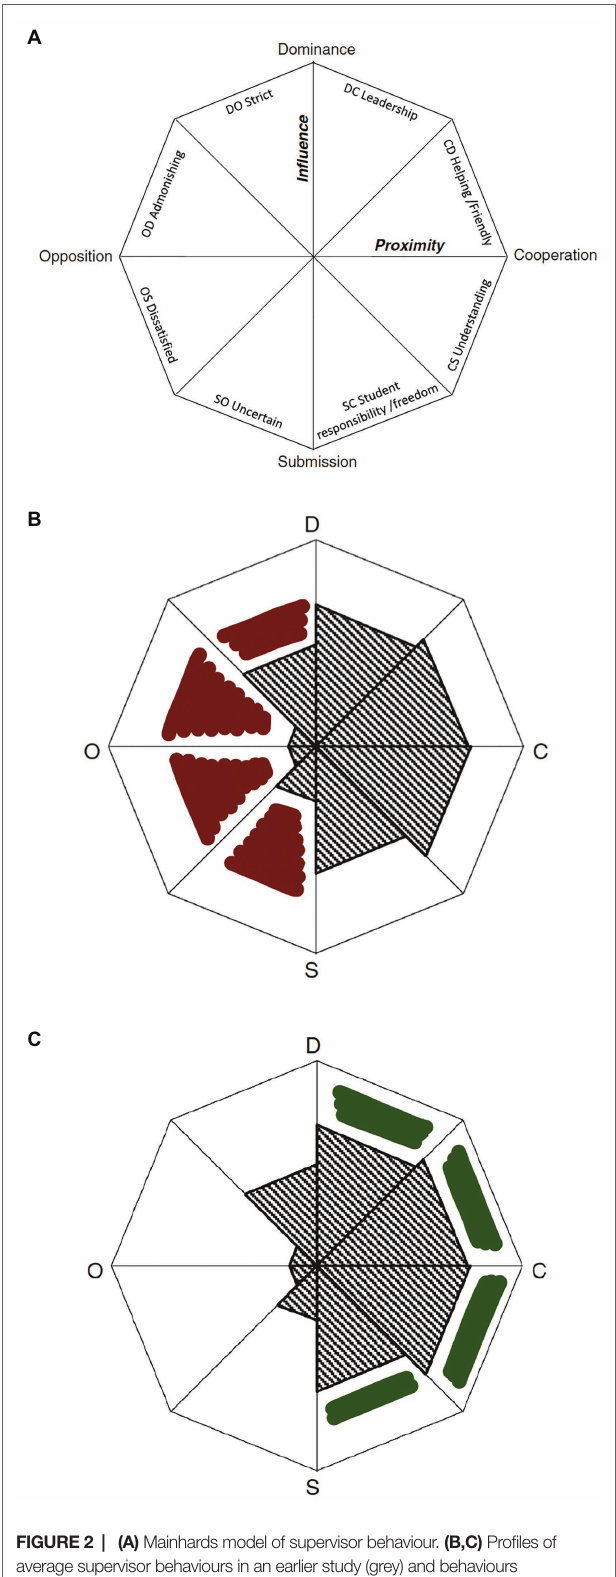
FIGURE 2 | (A) Mainhards model of supervisor behaviour. (B,C) Profiles of average supervisor behaviours in an earlier study (grey) and behaviours hypothetically linked to a lack of compassion (red) and behaviours that theoretically could be enhanced by compassion (green). Adapted from Mainhard et al. (2009).